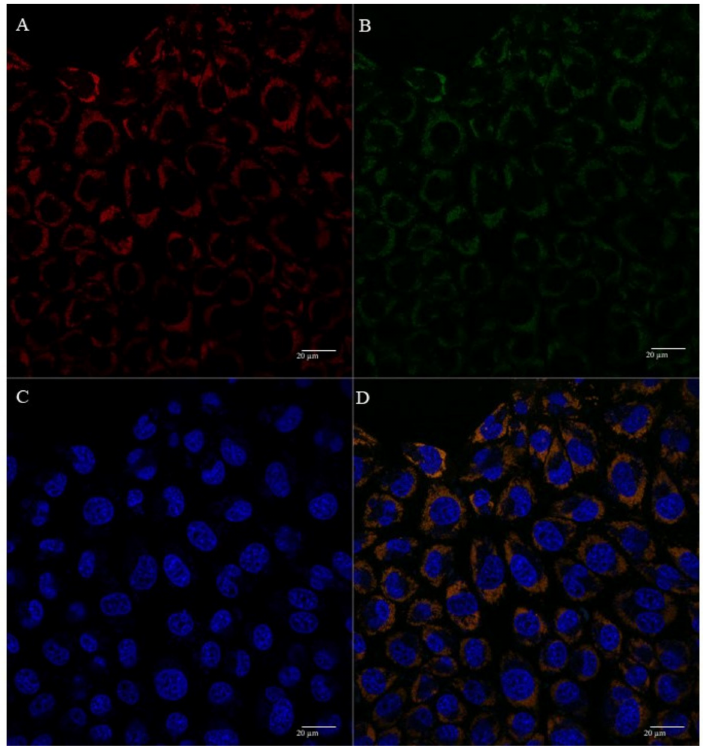
Figure 9. Representative confocal fluorescence image of HeLa cells, illustrating the transfection ability and intracellular co-localization of MTS-(KH) 9 /pND1 complexes formulated at an N/P ratio of 5. Mitochondria stained red by MitoTracker ( A ), pND1 green, labeled ( B ), nucleus marked blue by DAPI ( C ), and merged image ( D ). Scale bar = 20 µ